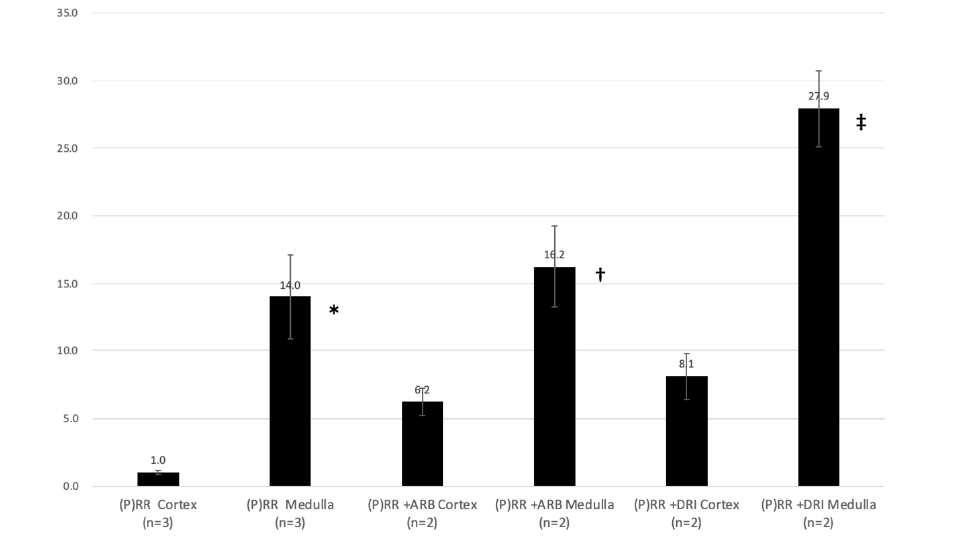
Figure 3. Expressions of (P)RR transgene relative to (P)RR cortex were shown. Results of qRT-PCR of (P)RR transgene in the kidneys of (P)RR-TG mice. Expression levels of transgenes were higher in the renal medulla than in the cortex. Data were analyzed using one-way ANOVA.